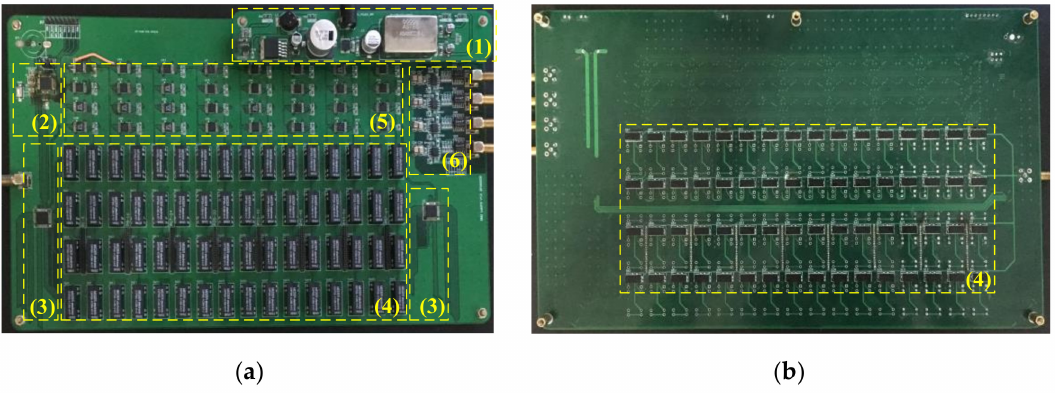
Figure 9. The matrix switcher PCB. ( a )Top view; ( b ) Bottom view.